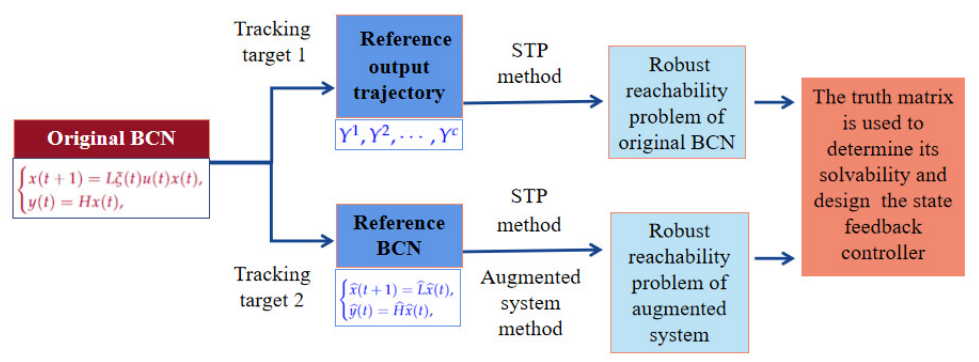
Figure 7. The methodology and outline of this